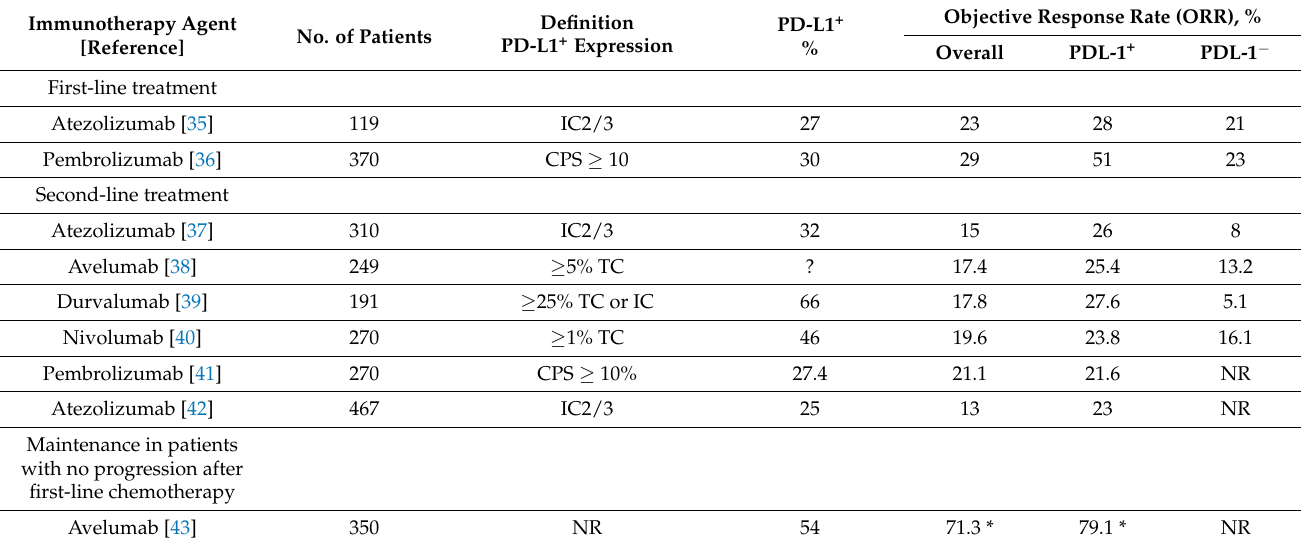
Table 3. Immunotherapies for first-line and second-line metastatic urothelial carcinoma: PD-L1 expression and response. Immunotherapy Agent